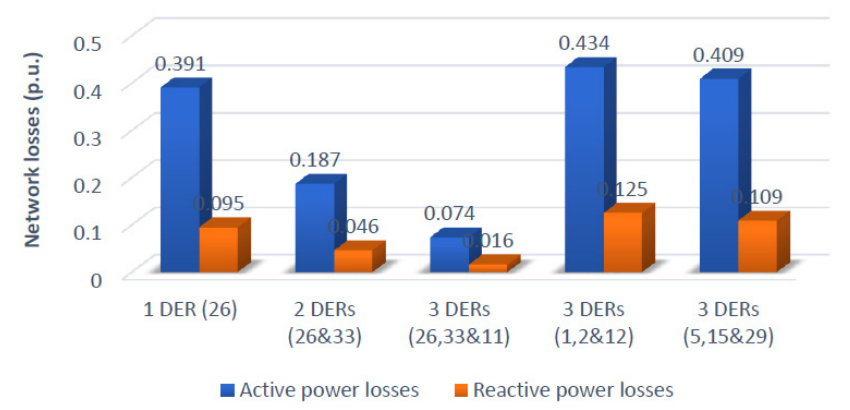
Figure 9. Comparison of system losses after DER units placement.